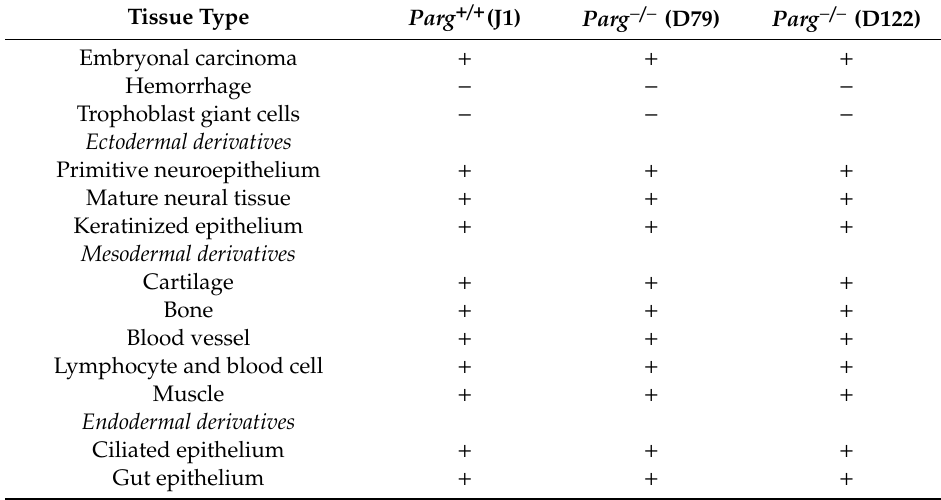
Table 1. Tissue components in tumors from Parg +/+ and Parg − / − ES cells. Tissue